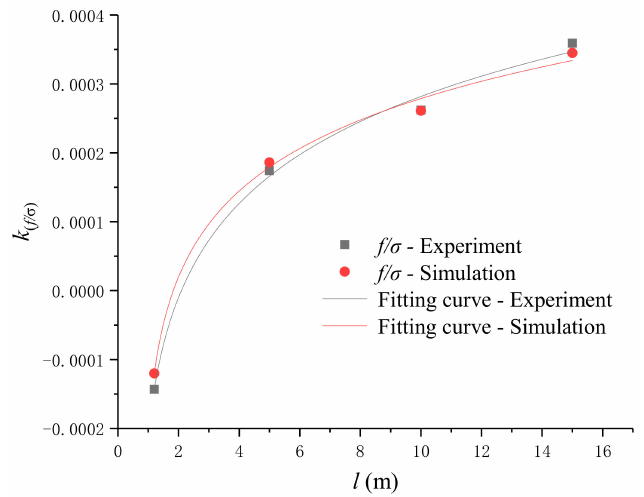
Figure 13. The length e ff ect